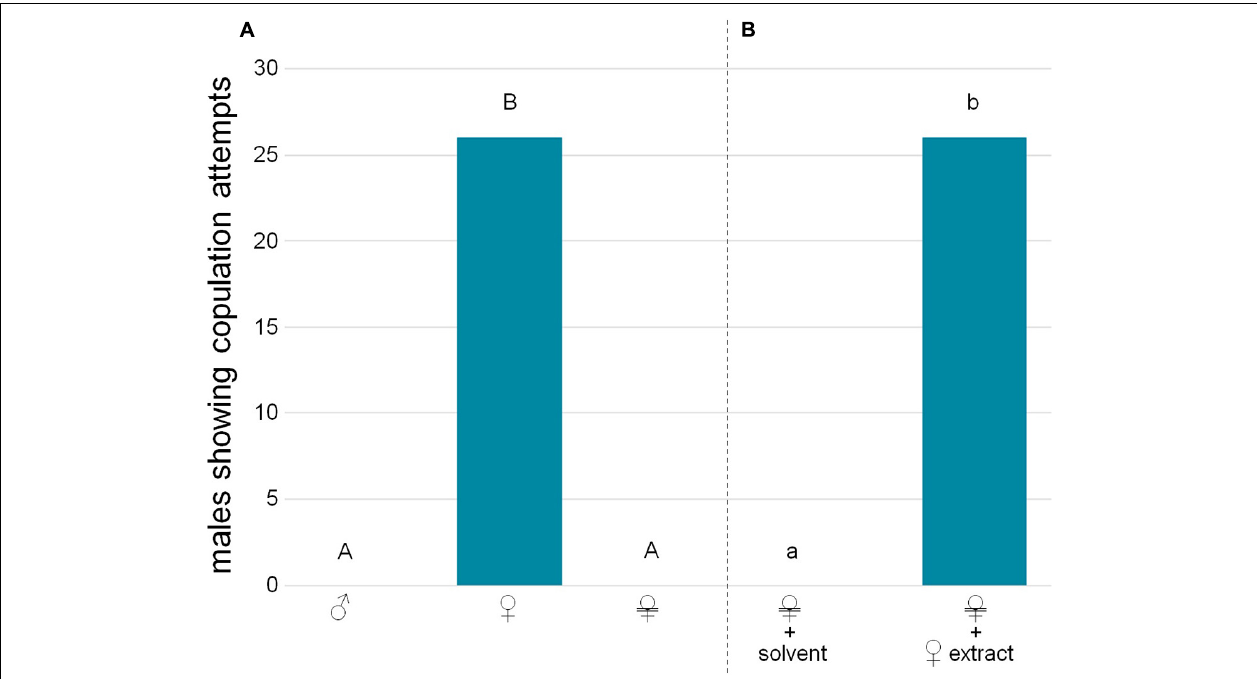
FIGURE 2 | Copulation attempts by virgin males. (A) Males were confronted with a dead male, a dead female, or a Soxhlet-extracted female (female symbol crossed with two horizontal bars). (B) Males were confronted with a Soxhlet-extracted female treated either with solvent (dichloromethane) or female-derived extract (two female equivalents). Significant differences in male reactions are depicted by different letters [ χ 2 tests, (A) with Bonferroni-Holm correction, capital letters, (B) lower case letters. In all significant cases p < 0.001, n = 30 for each group].